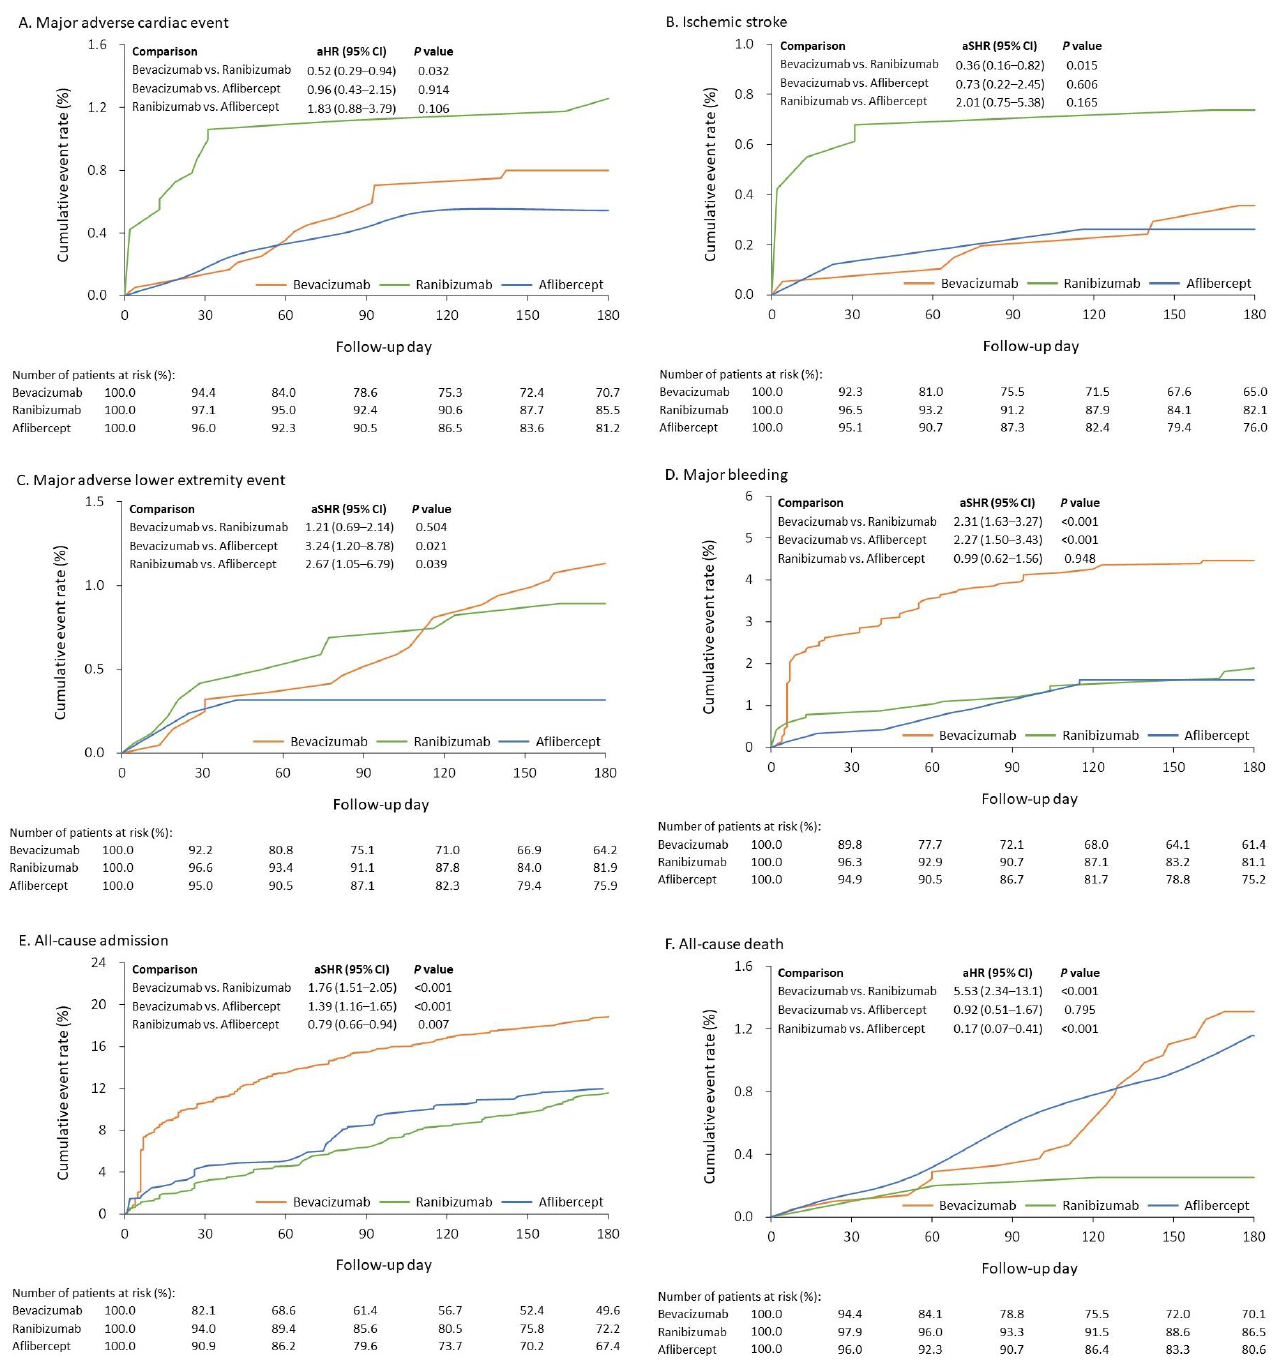
Figure 2. Cumulative event rate of ( A ) major adverse cardiac event, ( B ) ischemic stroke, ( C ) major adverse lower extremity event, ( D ) major bleeding, ( E ) all-cause admission, and ( F ) all-cause death for patients receiving different anti-vascular endothelial growth factor agents in the IPTW-adjusted cohort. aHR—adjusted hazard ratio; aSHR— adjusted sub-distribution hazard ratio; CI—confidence interval; IPTW—inverse probability of treatment weighting.